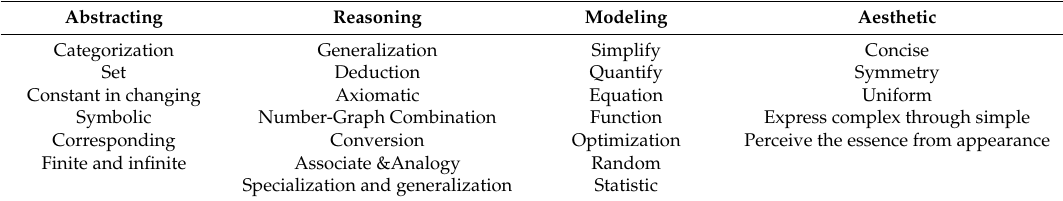
Table 4. The types of MT under abstracting, reasoning and modeling (Shi, 2011).